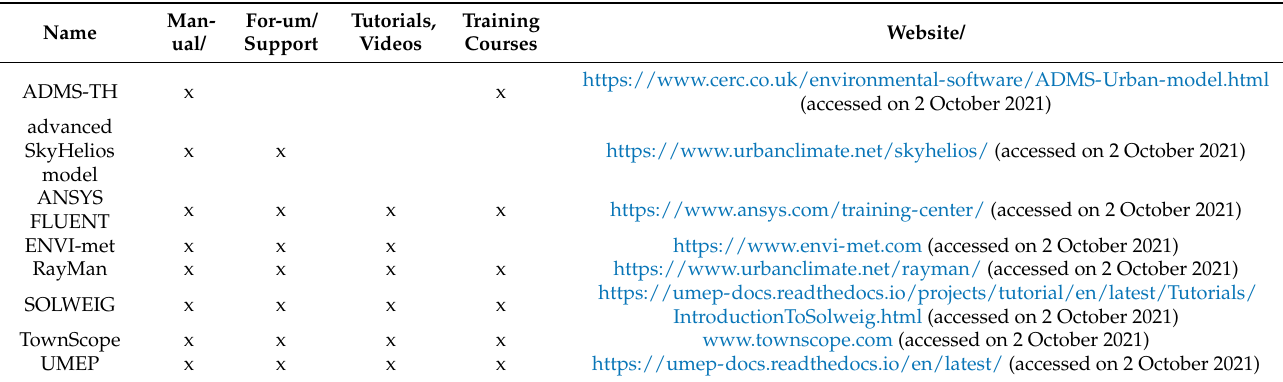
Table 3. Overview of available support and training material for the user-friendly models. X indicated that the information is